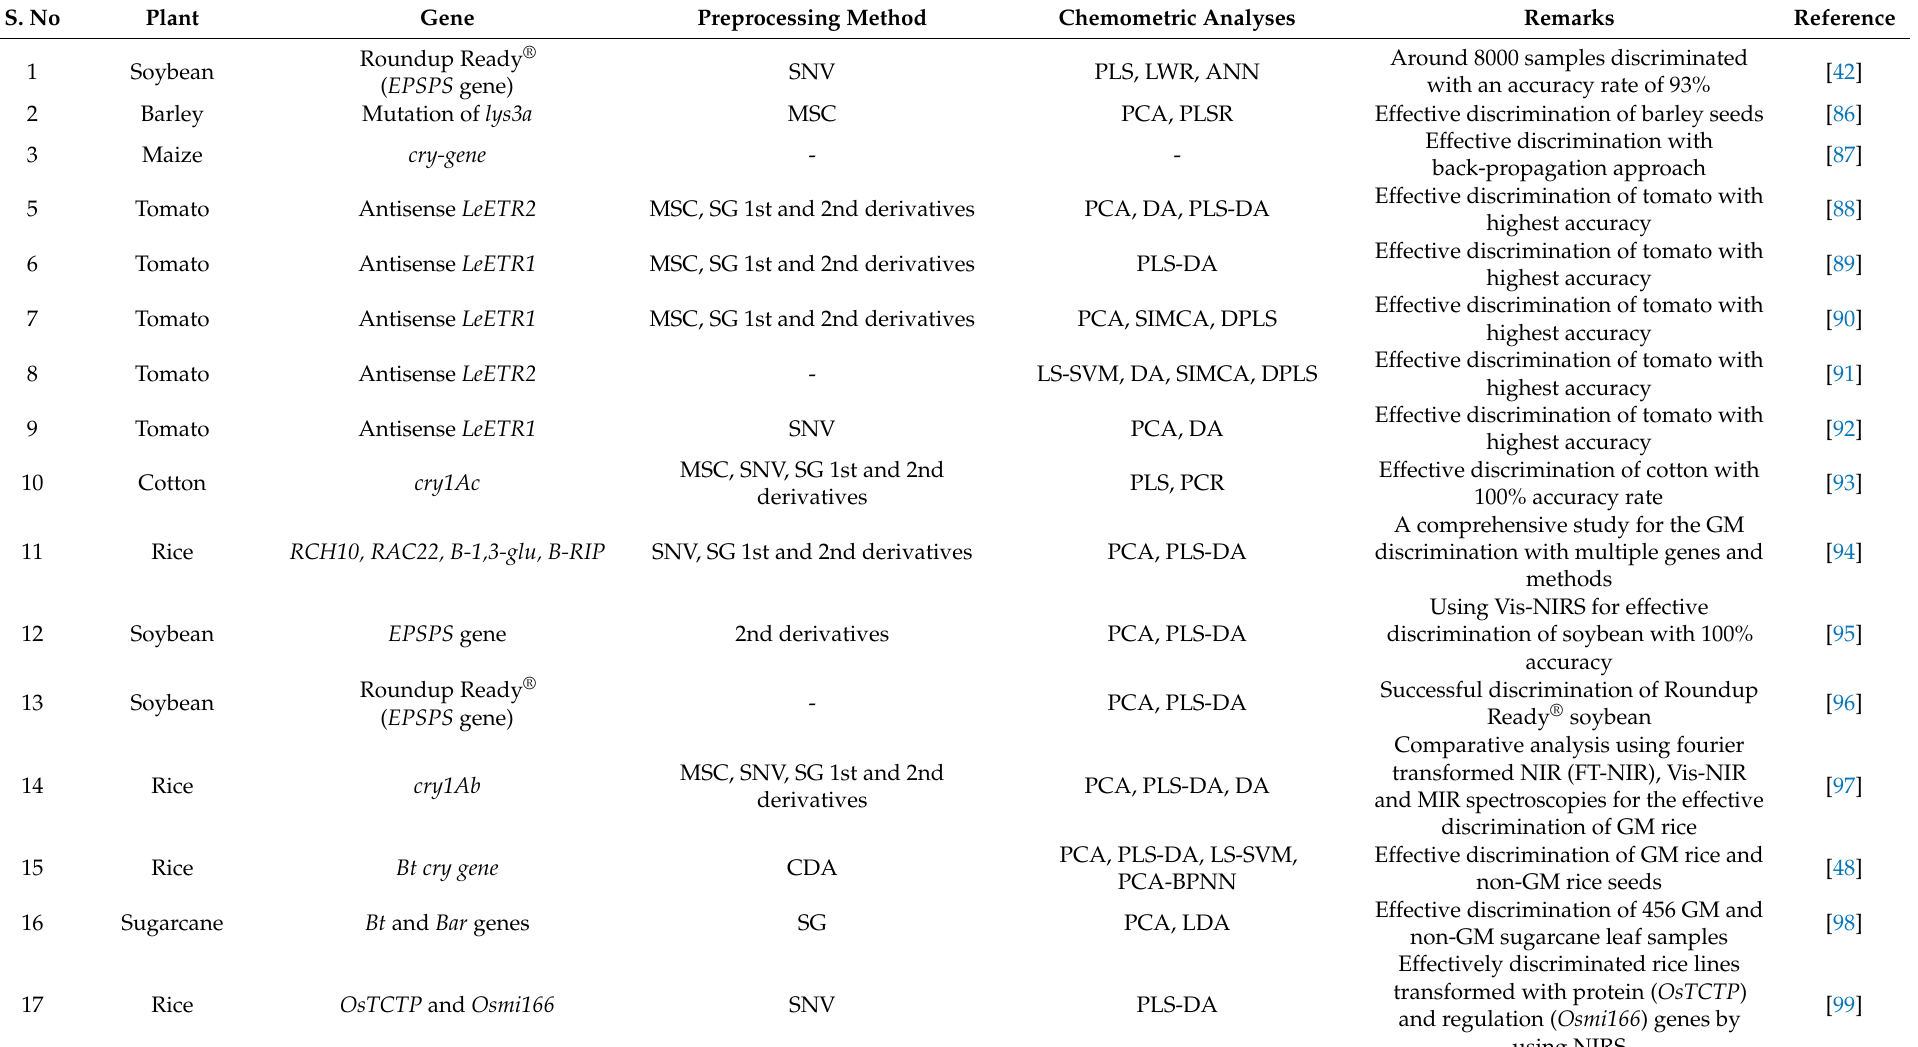
Table 2. Studies on genetically modified organism detection using near infrared